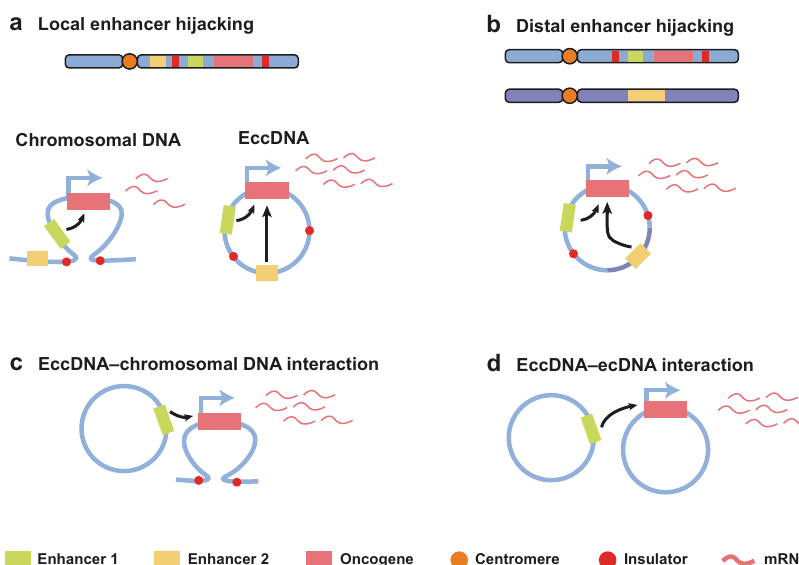
Fig. 4 EccDNA enables distal DNA interactions. a Oncogene segments and enhancers from adjacent topologically related domains can join together into a circle. b EccDNA integrates oncogene segments and distant enhancers to form an ecDNA circle. c , d EccDNA serves as a mobile enhancer that interacts with both chromosomal DNA ( c ) and other eccDNA ( d